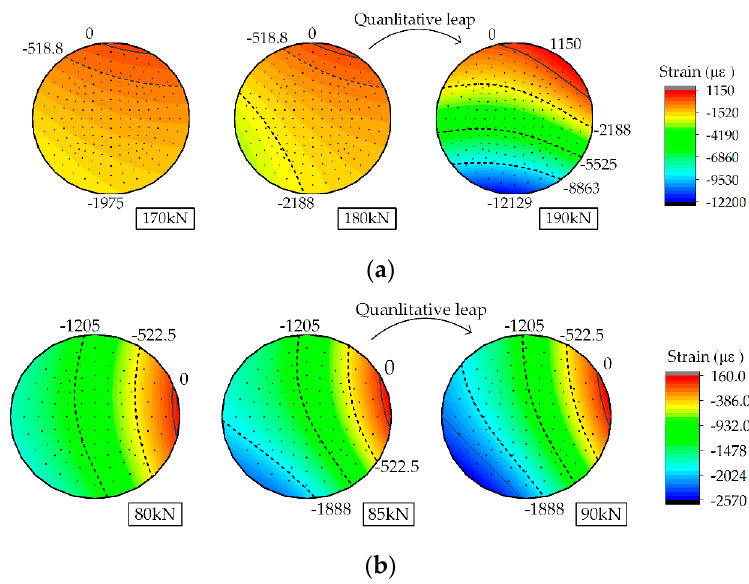
Figure 10. Strain fields of two arch models around characteristic loads Q : ( a ) Section 11 of arch-A; ( b ) Section 13 of arch-B.